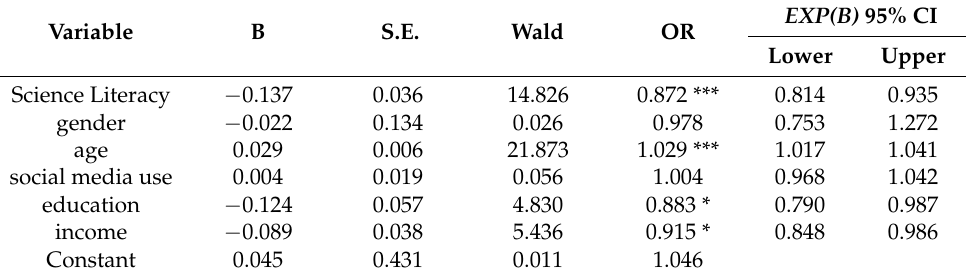
Table 2. Logistic Regression Analyses.